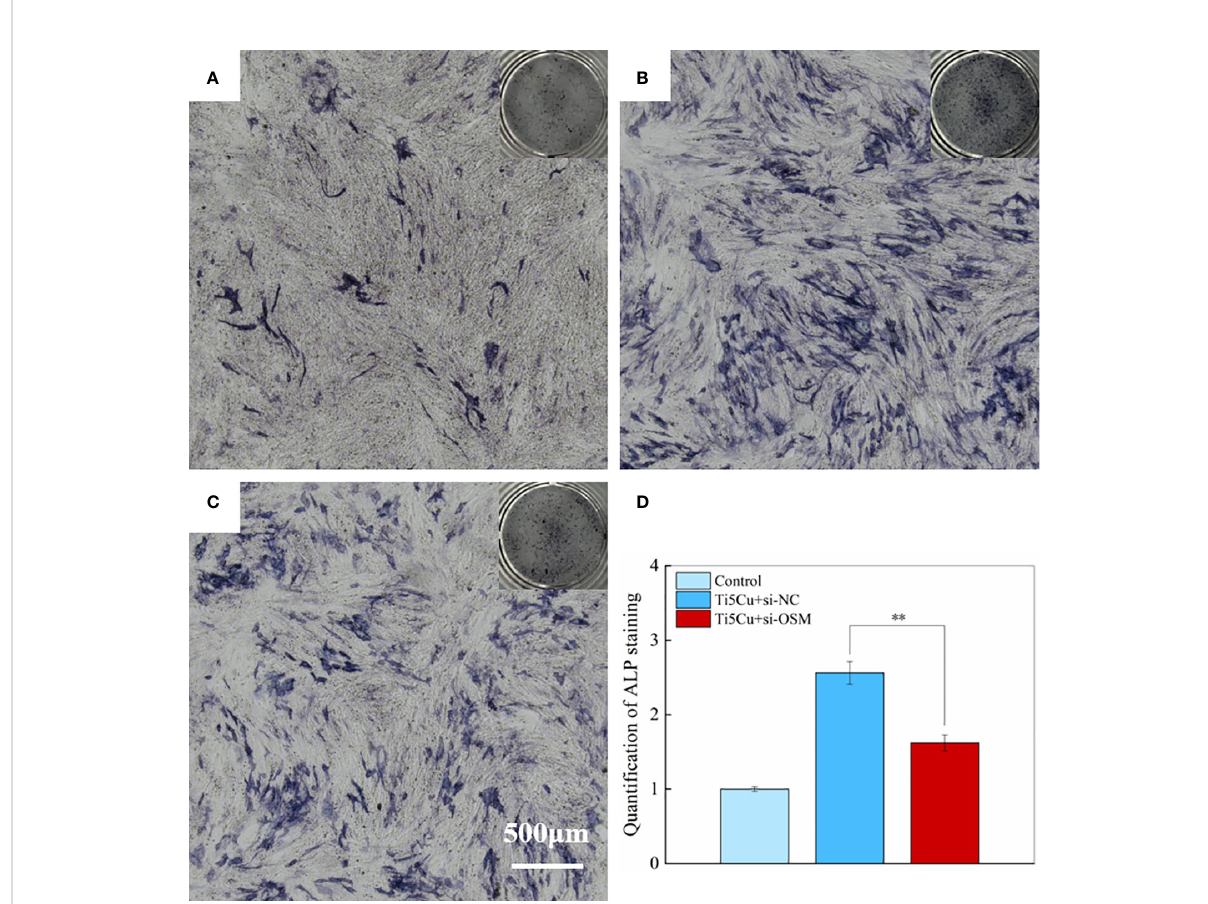
FIGURE 11 The ALP staining of MC3T3-E1 cells after cultured with si-NC and si-OSM conditioned medium for 7 days. (A) Control group; (B) Ti5Cu + si-NC group; (C) Ti5Cu + si-OSM group; (D) quanti fi cation statistical analysis of ALP staining (n = 3; **p <